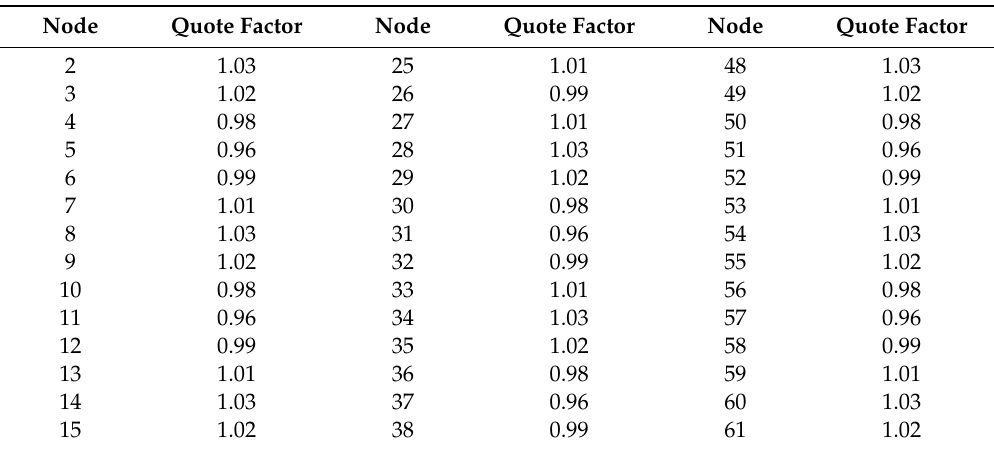
Table 3. User’s quote